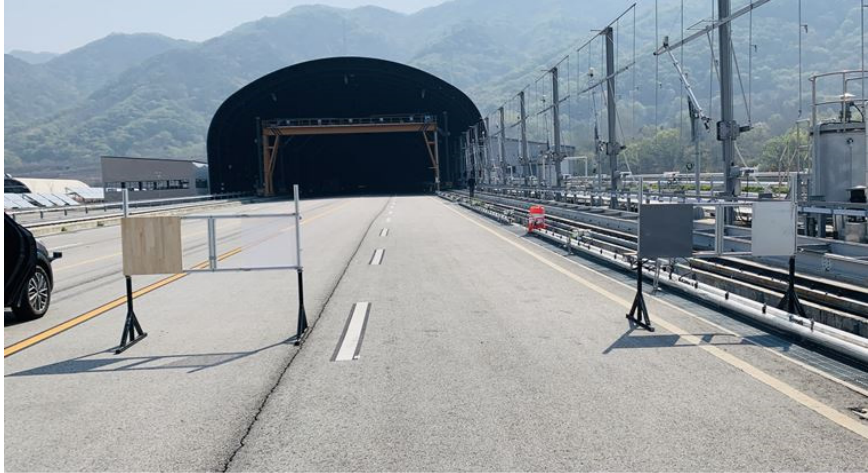
Figure 5. Object